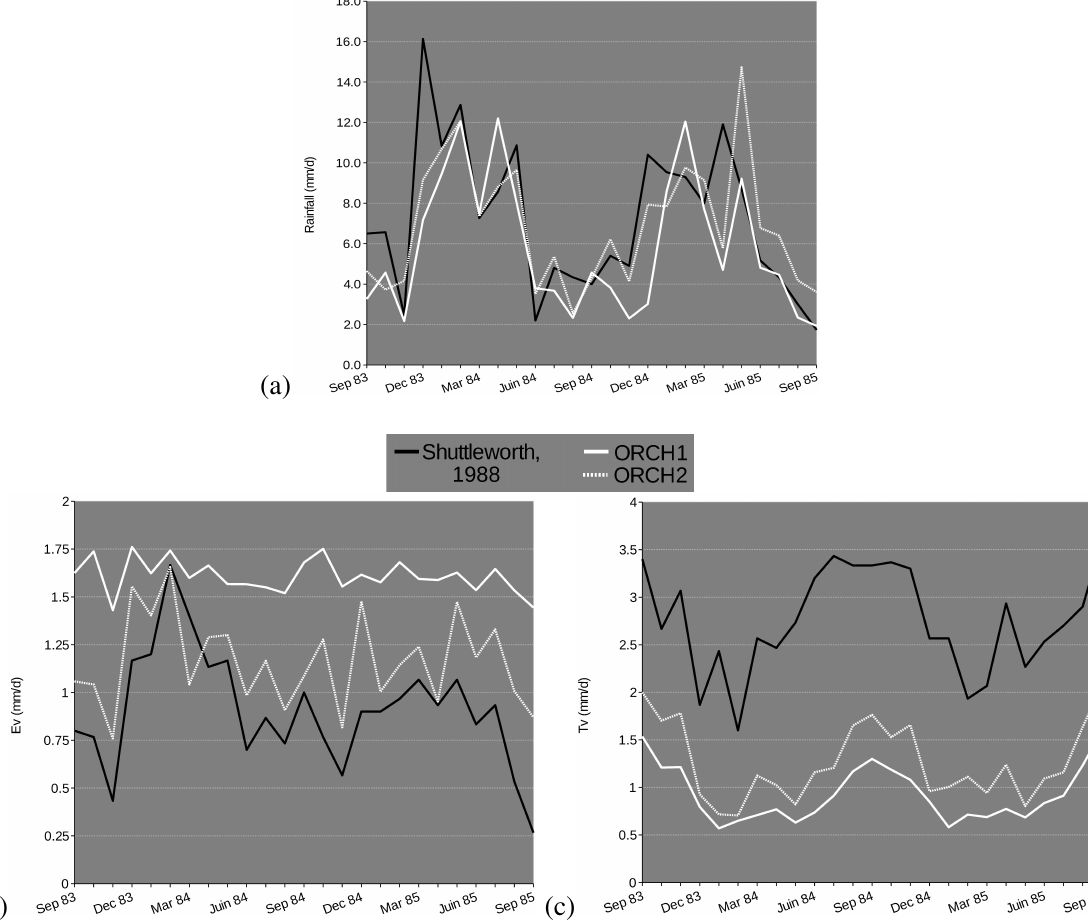
Fig. 8. Comparison of times series of (a) precipitation ( P ), (b) evaporation of water over the leaves ( E v ) and (c) transpiration ( T v ) (all in mm d − 1 ) between the two simulations (ORCH1 and ORCH2) and estimates from Shuttleworth (1988) near Manaus (Ducke Reserve), over the period September 1983–September 1985.